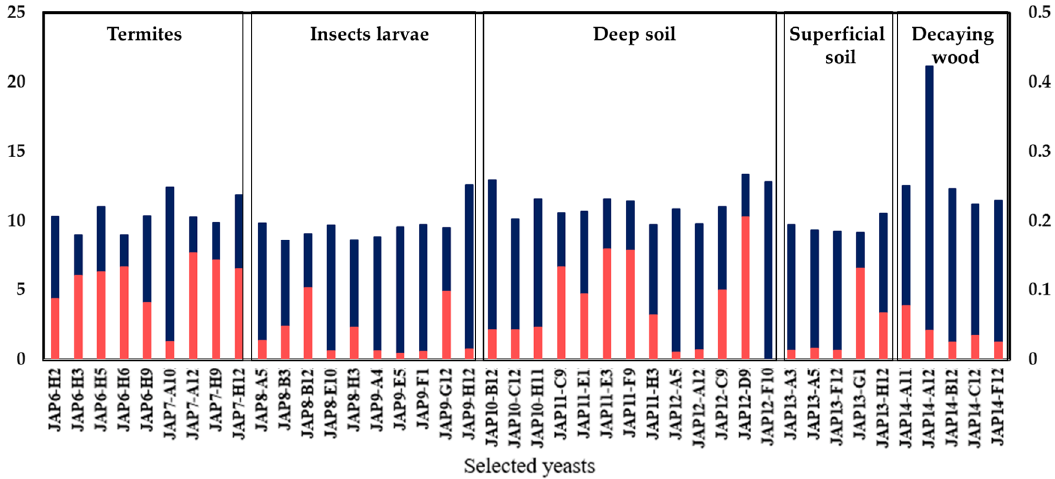
Figure 3. Xylose consumption and xylitol production after 48 h by the 42 selected yeast strains inoculated at a low cellular density in a defined medium supplemented with 40 g / L xylose. Grey lines (consumed xylose); black lines (xylitol production). The eight selected yeast strains are indicated by *.